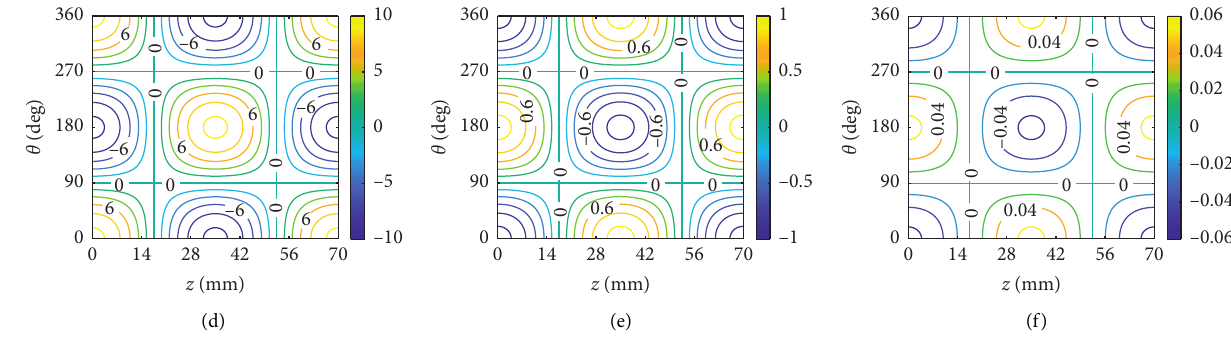
Figure 18: Contour map of axial displacement. (a) m � 1, n � 1, i � 1. (b) m � 1, n � 1, i � 2. (c) m � 1, n � 1, i � 3. (d) m � 2, n � 1, i � 1. (e) m � 2, n � 1, i � 2. (f) m � 2, n � 1, i �